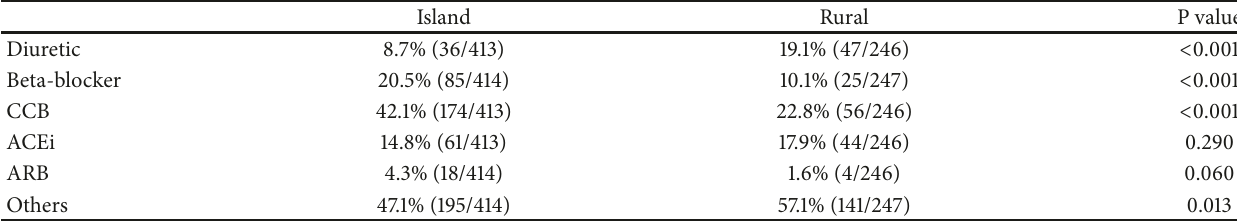
Table 7: Hypertensive mono medication status in island and rural residents.